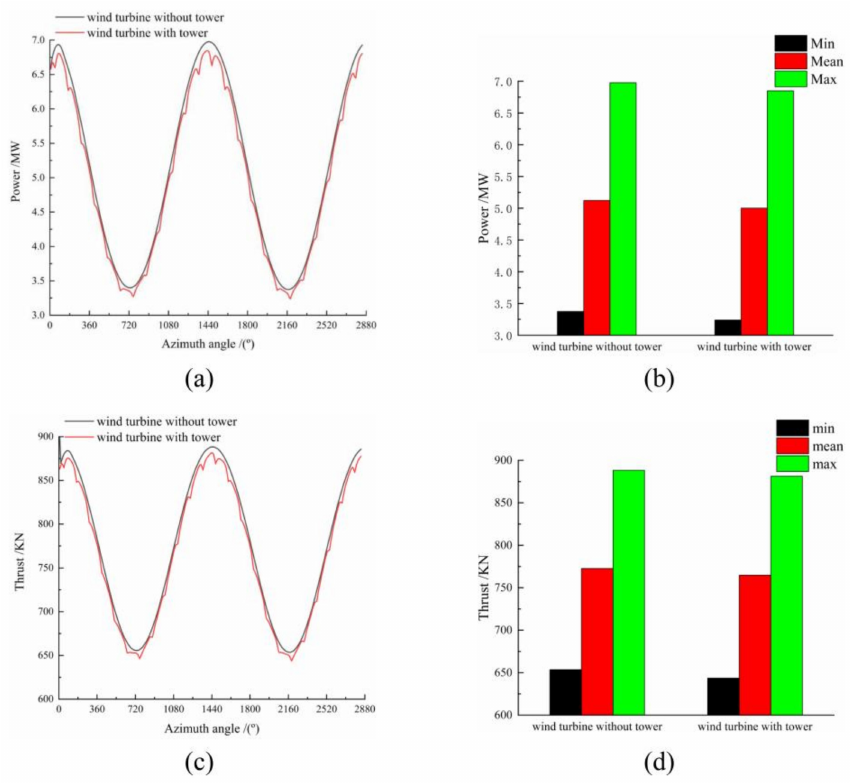
Figure 7. Total aerodynamic comparison of surge motion; ( a ) power versus azimuth angle; ( b ) ex- treme and average values of power; ( c ) thrust versus azimuth angle; ( d ) extreme and average values of thrust.